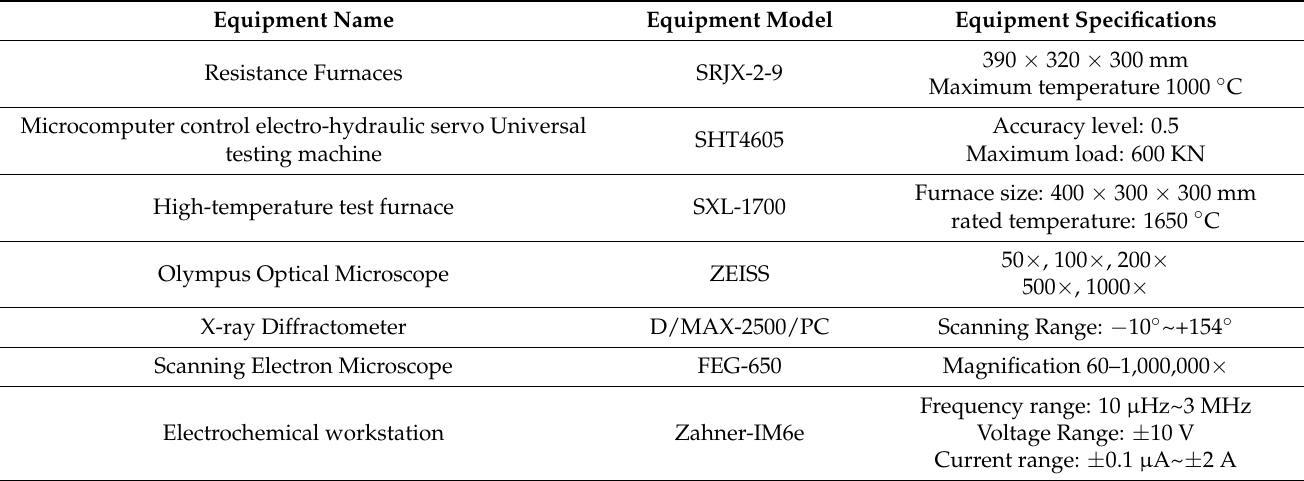
Table 2. Main equipment of the